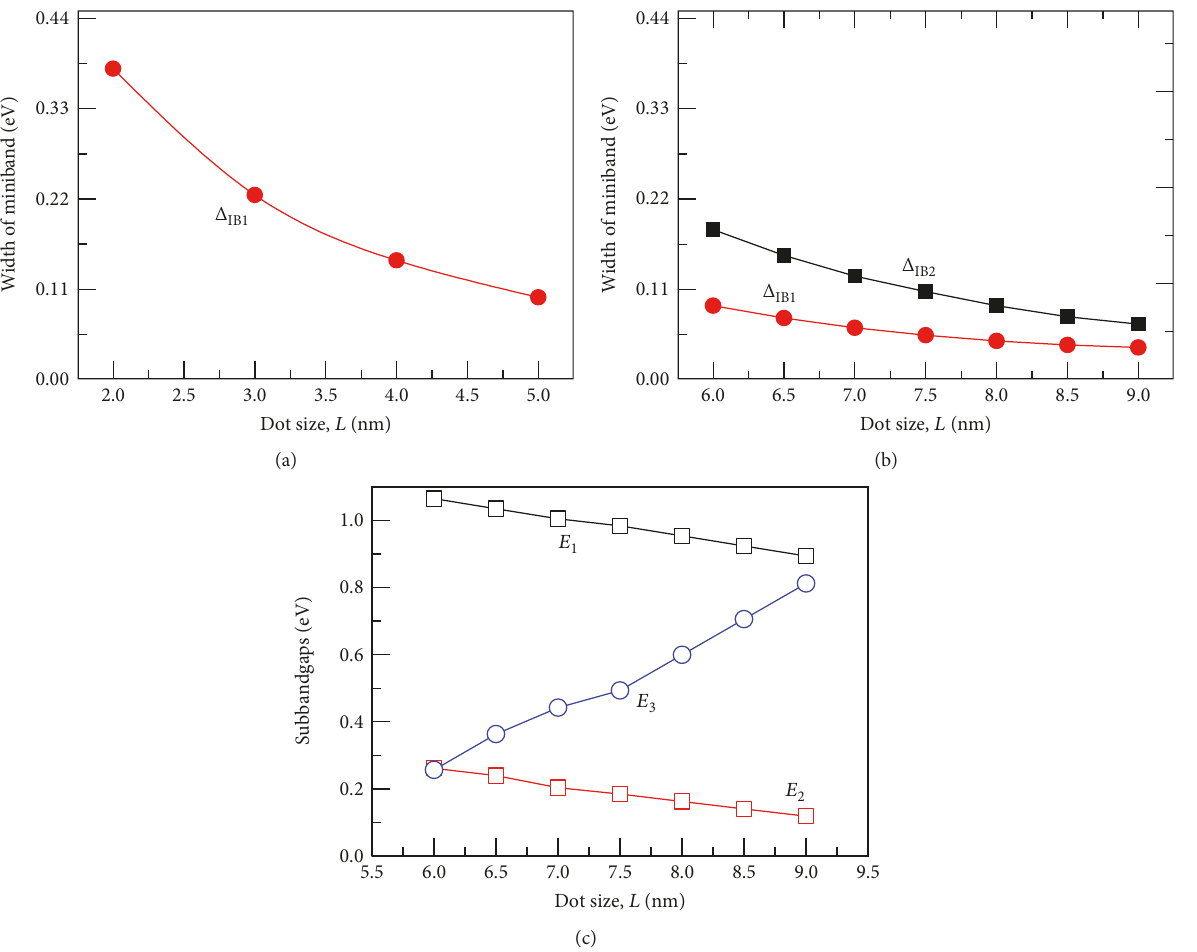
Figure 7: (a) Variation of Δ subbandgaps E